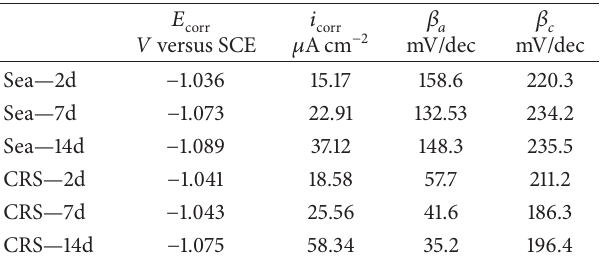
Table 1: Electrochemical parameters of galvanized steel calculated from polarization curve at 0.1MPa and 293 K in seawater and CRS